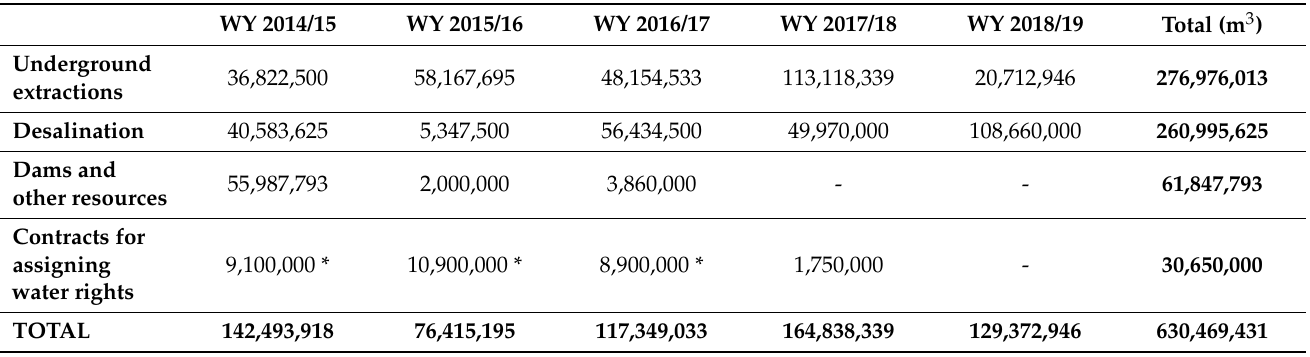
Table 17. Maximum authorised extraordinary resources (m 3 /year). Source: own elaboration based on [70,72].